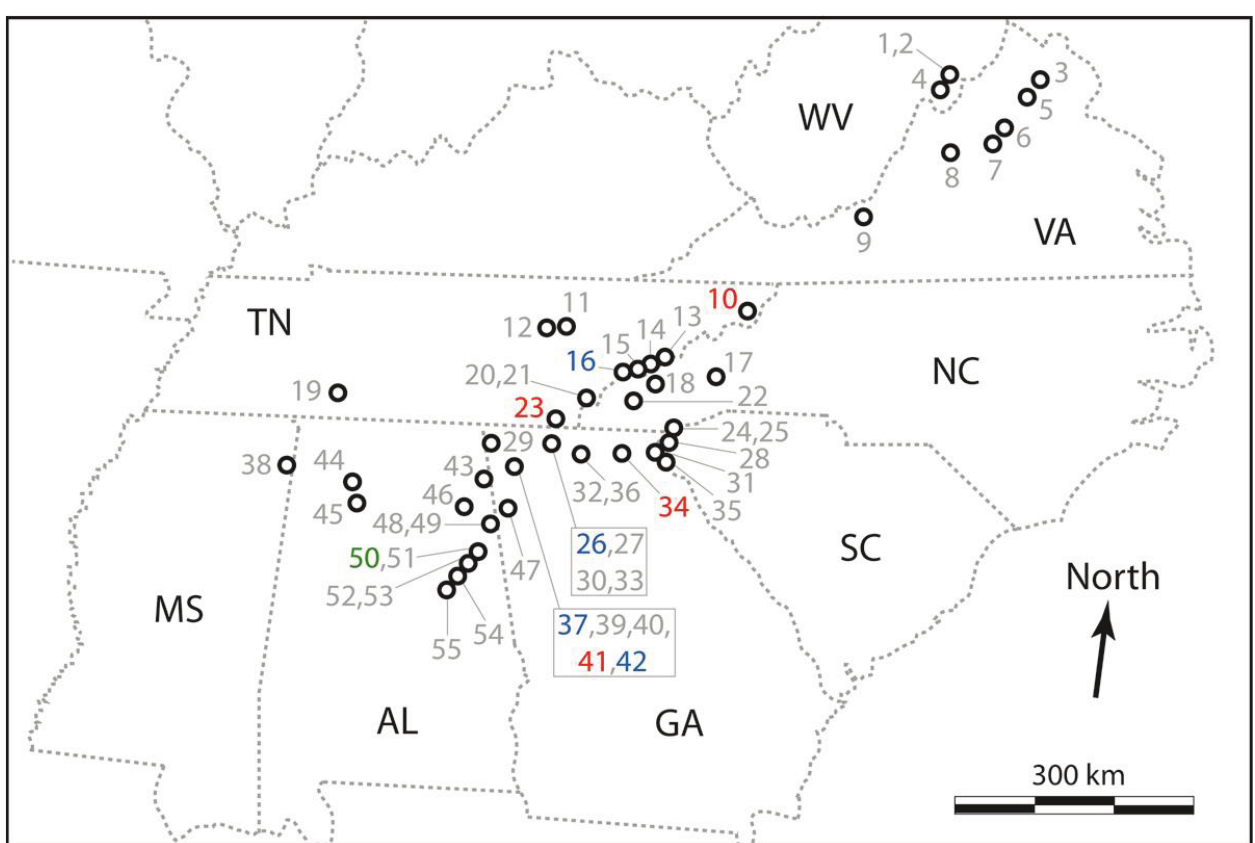
Figure 1. Map of collection sites of Reticulitermes specimens used as a “test panel” when assessing performance of the new PCR-RFLP assay. Sites are represented as black circles, numbered sequentially from 1 – 55 according to latitude, corresponding with Table S1 (grey numbers indicate sites from which R. flavipes were sampled, red = R. virginicus , blue = R. malletei , and green = R. nelsonae ). States are represented by dashed grey lines, and those from which termites were collected are labelled with abbreviations (black text) as follows: Mississippi, MS; Alabama, AL; Georgia, GA; Tennessee, TN; South Carolina, SC; North Carolina, NC; Virginia, VA; and West Virginia,